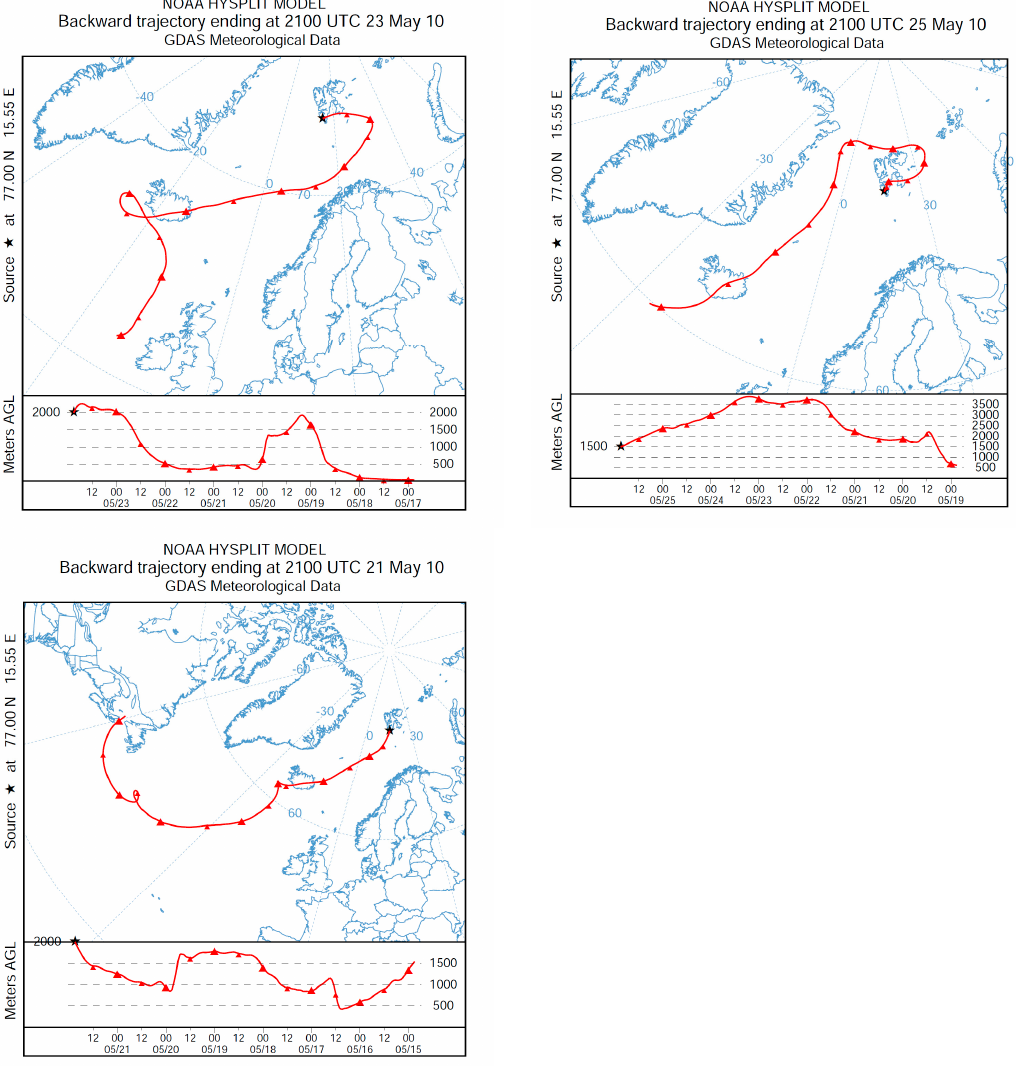
Figure 9. Trajectories of air masses inflow in the region of Polish Polar Station at Hornsund fjord during Eyjafjallajökull eruption in 2010.